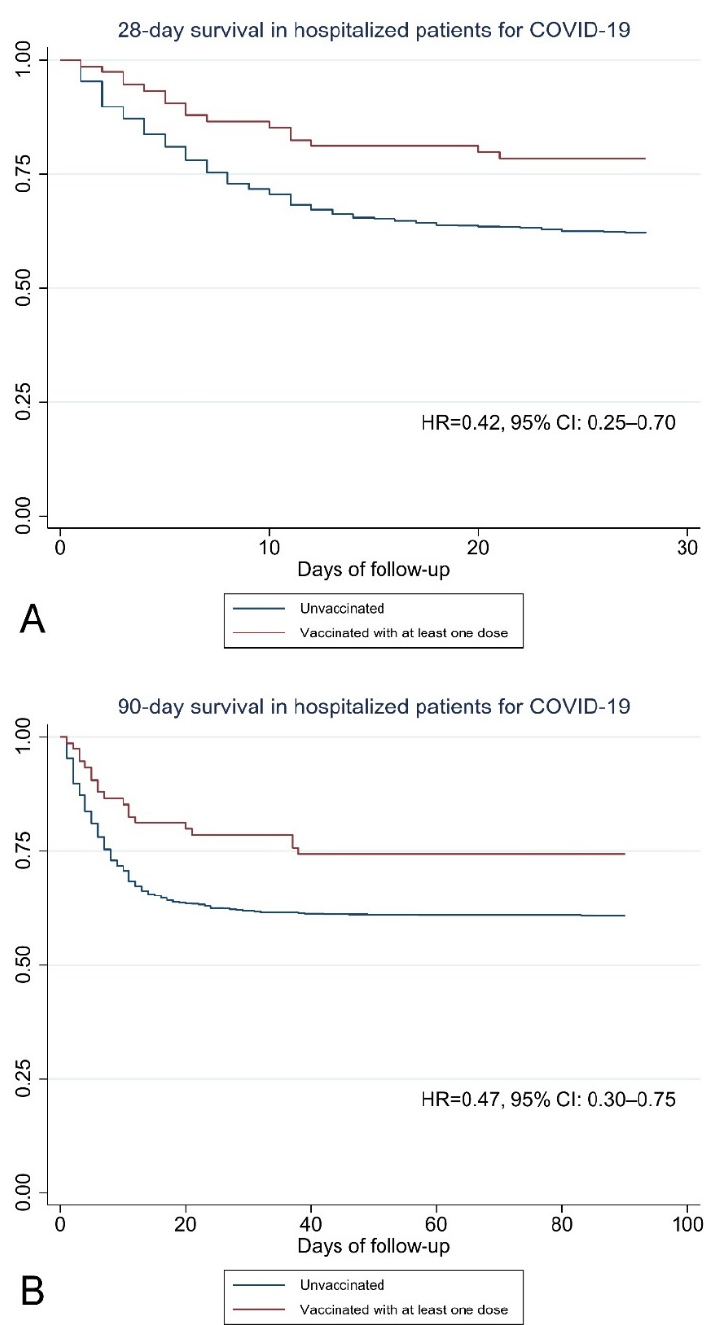
Figure 1. Survival of patients hospitalized for COVID-19 according to vaccination status. ( A ) Survival after 28 days. ( B ) Survival after 90 days.